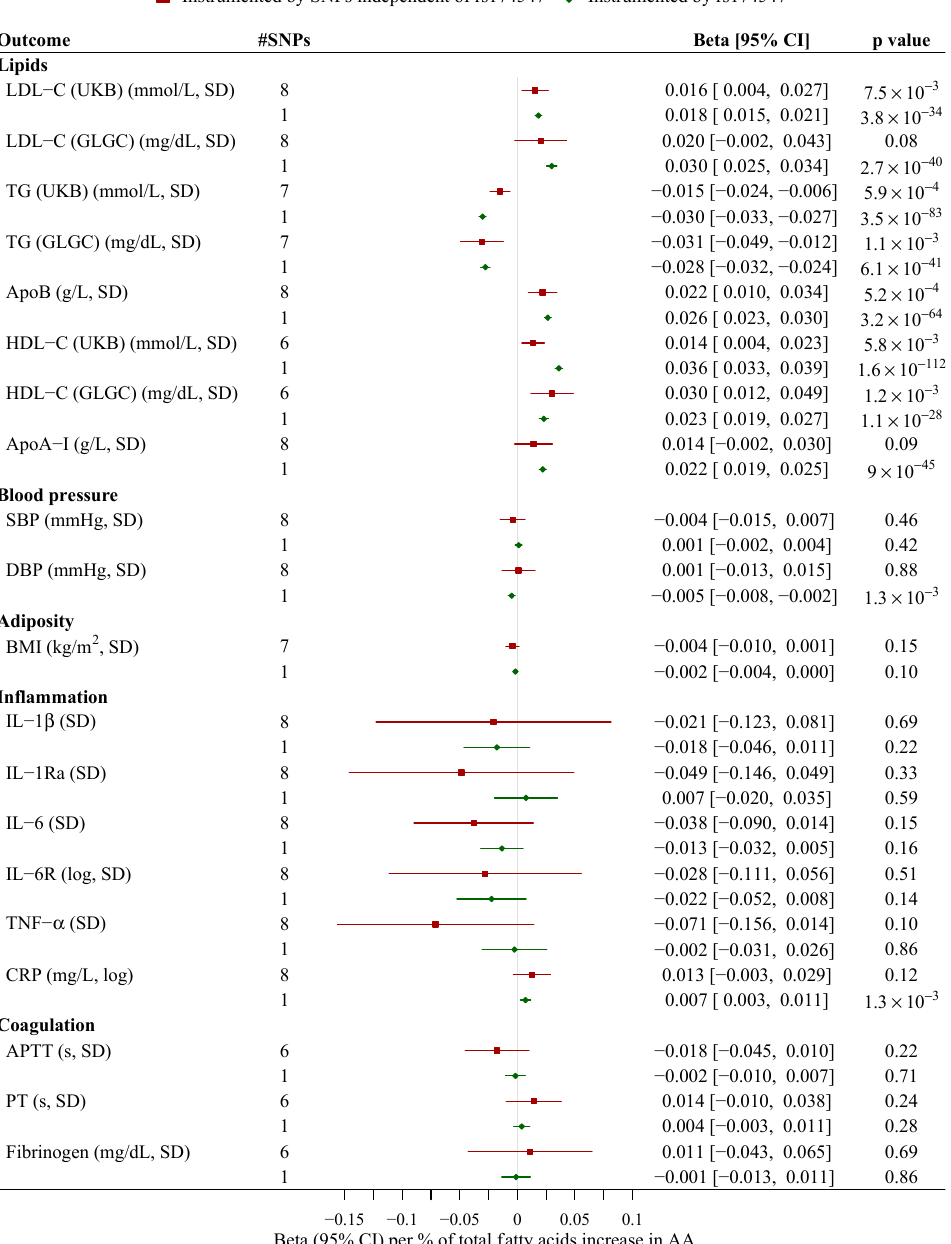
Figure 1. Associations of genetically predicted arachidonic acid synthesis with lipid profile, blood pressure, adiposity, and markers of inflammation and coagulation. The estimates based on SNPs independent of rs174547 were derived from inverse variance weighting with multiplicative random effects, while the estimates based on rs174547 were the Wald estimate. ApoA-I, apolipoprotein A-I; ApoB, apolipoprotein B; APTT, activated partial thromboplastin time; BMI, body mass index; CI, confidence interval; CRP, C-reactive protein; DBP, diastolic blood pressure; GLGC, the Global Lipids Genetics Consortium; HDL-C, high-density lipoprotein cholesterol; IL-6, interleukin-6; IL-6R, IL-6 receptor; LDL-C, low-density lipoprotein cholesterol; PT, prothrombin time; SBP, systolic blood pressure; SNP, single-nucleotide polymorphisms; TG, triglycerides; TNF- α , tumor necrosis factor- α ; UKB, UK